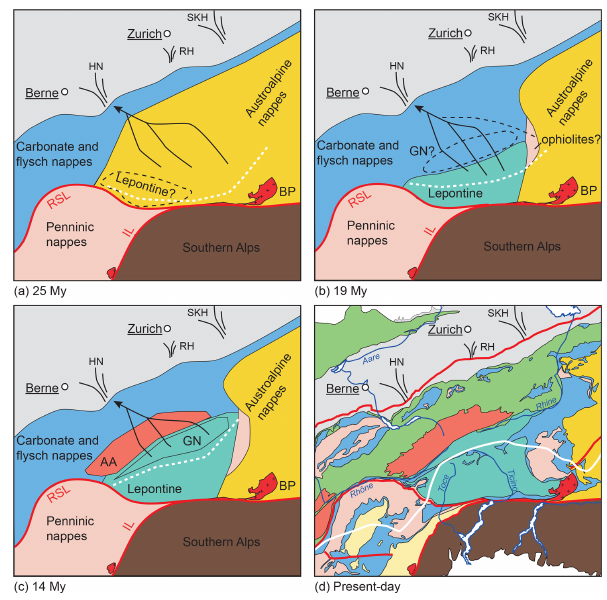
Figure 6. Paleogeographic reconstruction of the Central Alps and in particular of the hinterland of the Honegg–Napf fan. Situation during (a) the late Oligocene ( ∼ 25Ma), (b) the early Miocene ( ∼ 19Ma), (c) the middle Miocene ( ∼ 14Ma), and (d) today (after Schmid et al., 2004). The colour coding in (a–c) corresponds es- sentially to the colour coding in (d) (see Fig. 1 for detailed legend). However, we have summarized the lower, middle, and upper Pen- ninic nappes and the Dent Blanche nappe (pink colour) as well as the carbonate and flysch nappes of the Helvetic nappes and the Ro- mandes Prealps (blue colour). Abbreviations used: AA – Aar mas- sif; BP – Bergell pluton; GN – Gotthard nappe; HN –